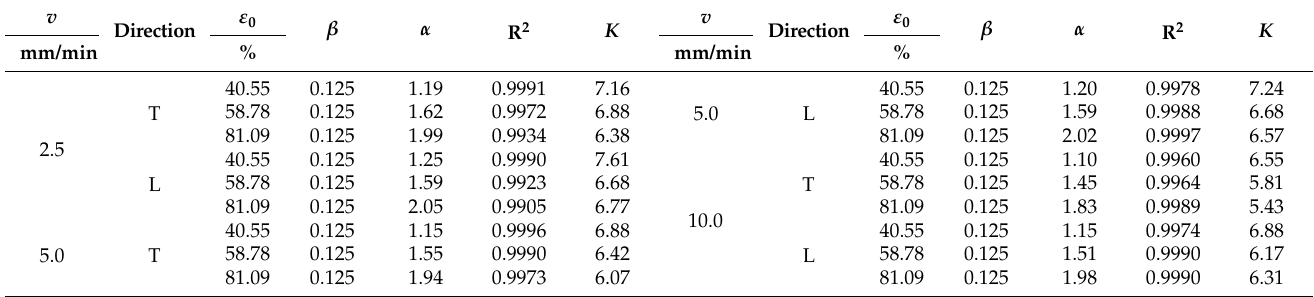
Table 2. Model parameters determined through fitting with the test